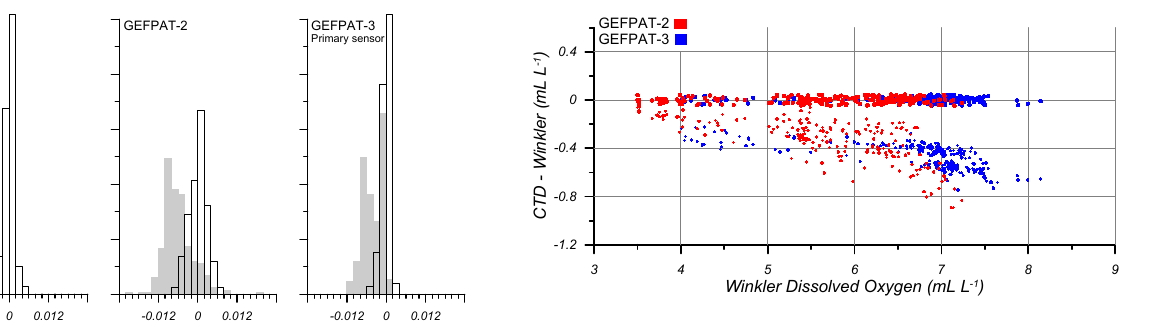
Figure 3. Distribution of dissolved oxygen residuals versus dis- solved oxygen concentration (both in mLL − 1 ) before ( + ) and after ( • ) SBE 43 sensor calibration for GEFPAT-2 (red) and GEFPAT-3